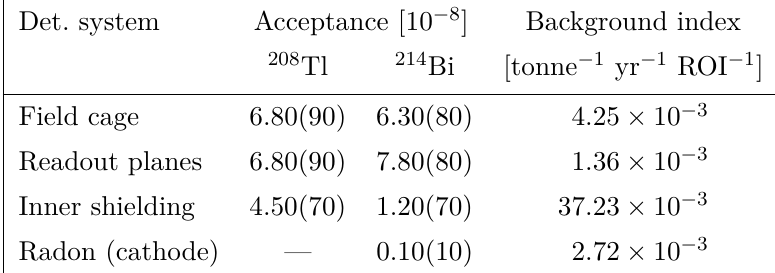
Table 2 . Acceptance factor (i.e., the probability of accepting a background event as signal) and resulting background indexes per unit of mass of 136 Xe for the natural-radioactivity background sources considered in the background model of NEXT-1t.